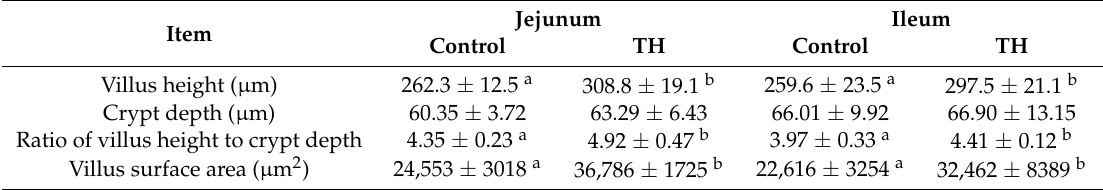
Table 3. Intestinal morphology indexes of piglets receiving dietary supplementation with or without trihexanoin (TH).